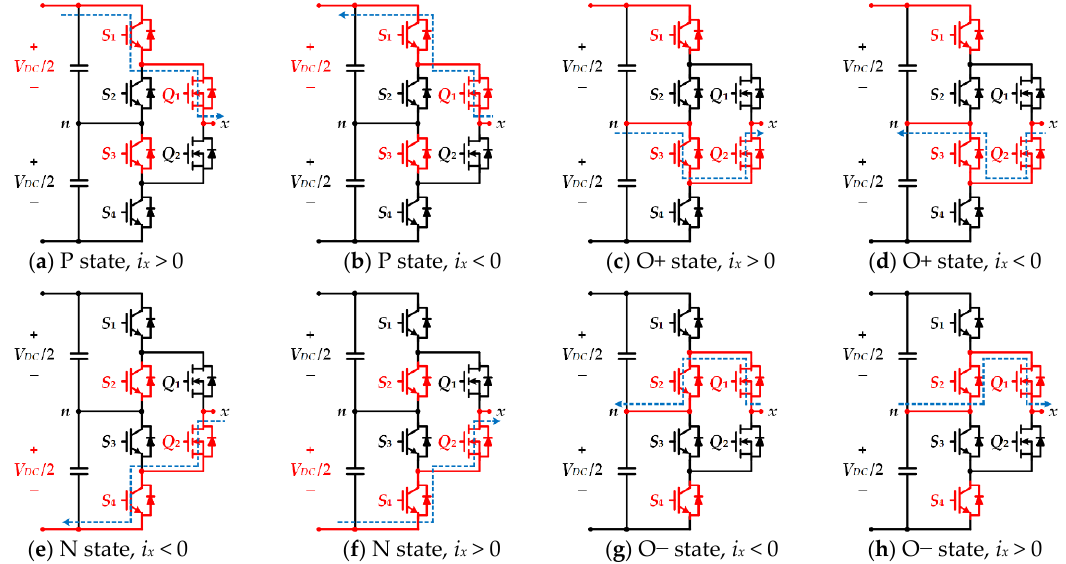
Figure 4. Switching states and current path of the HANPC rectifier. Table 1. Switching states and output pole voltage in accordance with on-off state of each switch in the HANPC topology (1: on, 0: off).